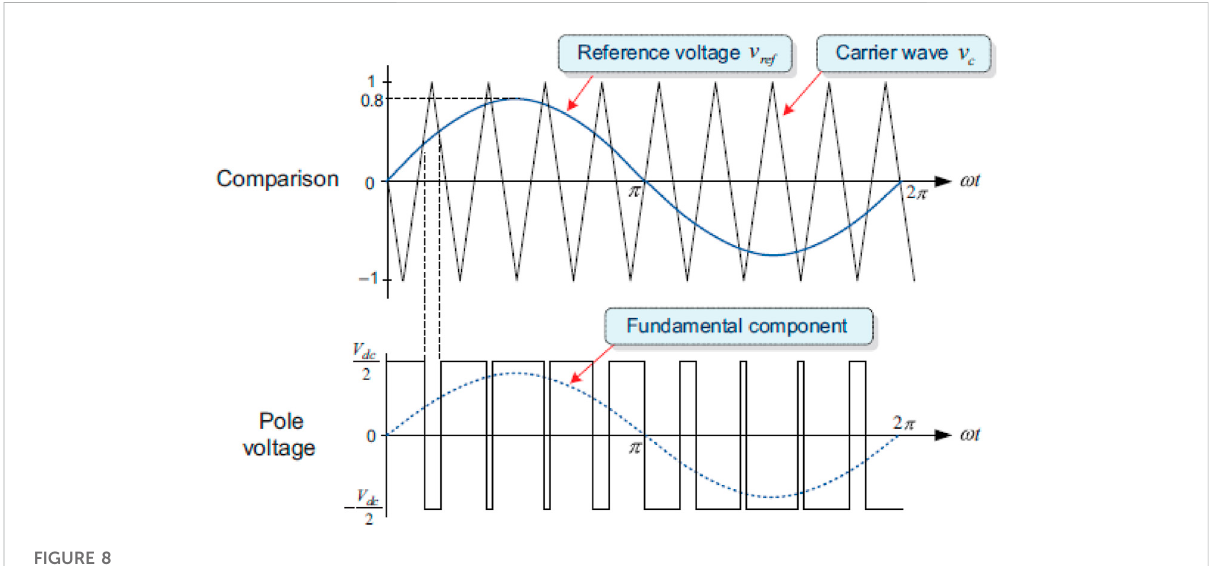
FIGURE 8 The sinusoidal PWM technique process (Kim,